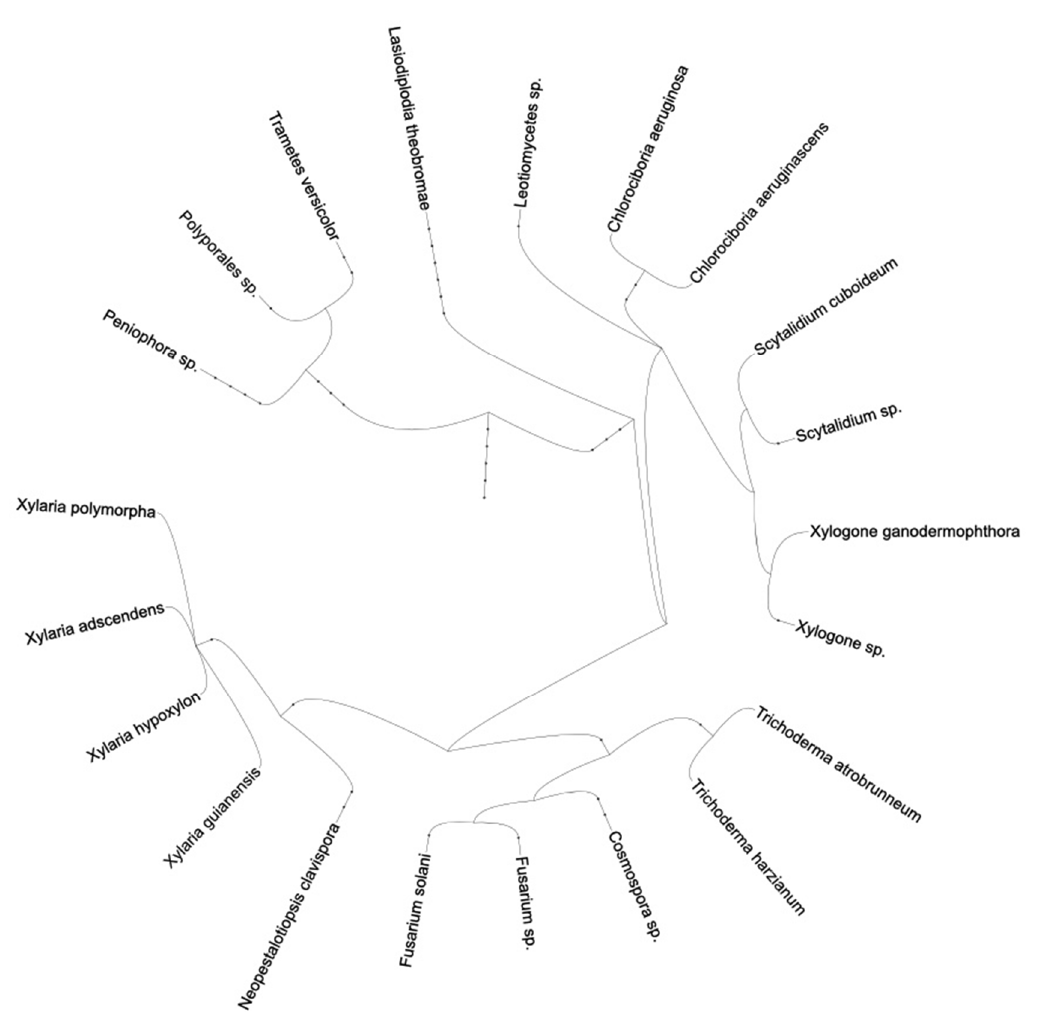
Figure 1. Phylogenetic tree of the species found in this study.